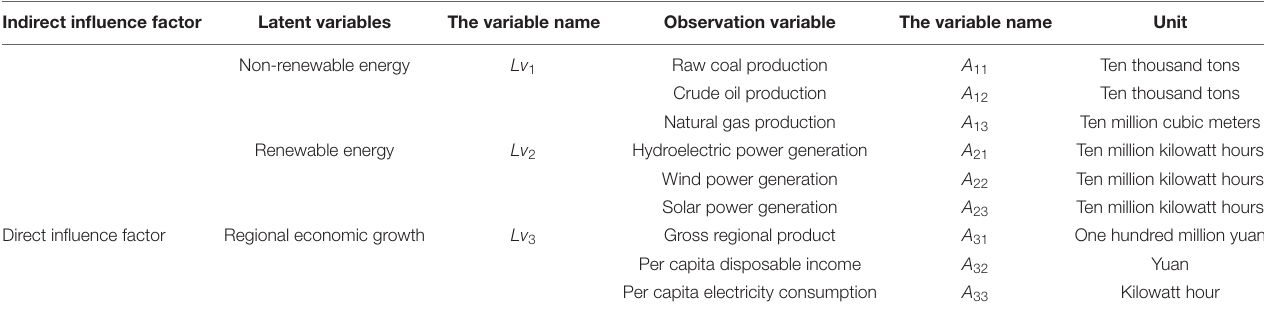
TABLE 1 | Evaluation index system of China’s regional energy development